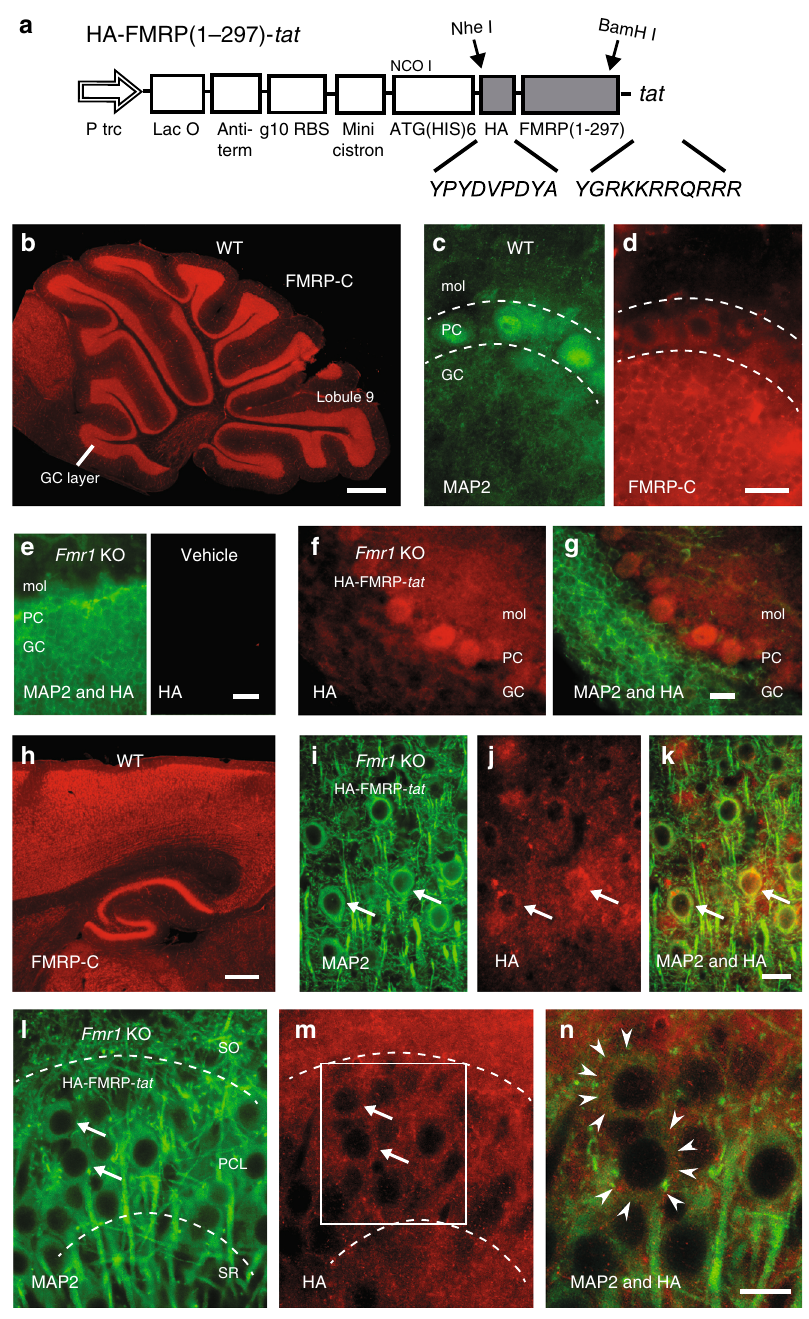
Fig. 4 A FMRP(1 – 297)- tat construct rapidly crosses the BBB to enter central neurons. a Schematic diagram of HA-FMRP(1 – 297)- tat construct. HA sequence and 11 aa tat sequence were inserted through the two restriction enzyme sites indicated by arrows . b – d Immunolabel distribution for an FMRP C-terminus (FMRP-C) antibody in WT mouse cerebellum with expanded views of dual labeled MAP2 ( c ) and FMRP-C ( d ) in lobule 9 cell layers. e – g Cerebellar sections from Fmr1 KO mice that were tail vein injected with either vehicle ( e ) or 1.0 mg/kg HA-FMRP(1 – 297)- tat ( f , g ) and processed 30 min later for MAP2 and HA labeling. HA label is absent in vehicle-injected Fmr1 KO mouse cerebellum ( e ) but is detected in all cell layers after tail vein injection of HA-FMRP(1 – 297)- tat ( f , g ). h Low power view of immunolabel for the FMRP-C antibody in WT mouse in the region of neocortex and hippocampus. i – n Magni fi ed views of Fmr1 KO mouse neocortex at 30 min ( i – k ) and CA3 hippocampus at 12 h ( l – n ) following tail vein injection of 1.0 mg/kg HA-FMRP(1 – 297)- tat and dual labeled for MAP2 and HA. Boxed region in ( m ) is magni fi ed in ( n ), with the boundaries of cell membranes of hippocampal pyramidal cells denoted by arrowheads in ( n ) to distinguish FMRP(1-297) immunolabel in cytoplasmic regions. Dashed lines in ( c , d ) and ( l , m ) delineate major cell boundaries and arrows in ( l , m ) highlight representative cells exhibiting both MAP2 and HA immunolabels. Animals used for immunolabeling ranged from P25 – P40, with immunolabel experiments conducted in at least 3 separate animals in ( b – n ). GC granule cell layer, PC Purkinje cell layer, mol molecular layer, SR stratum radiatum, PCL pyramidal cell layer, SO stratum oriens. Scale bars: b , h , 500 µ m; c – g , i – n , 20 µ